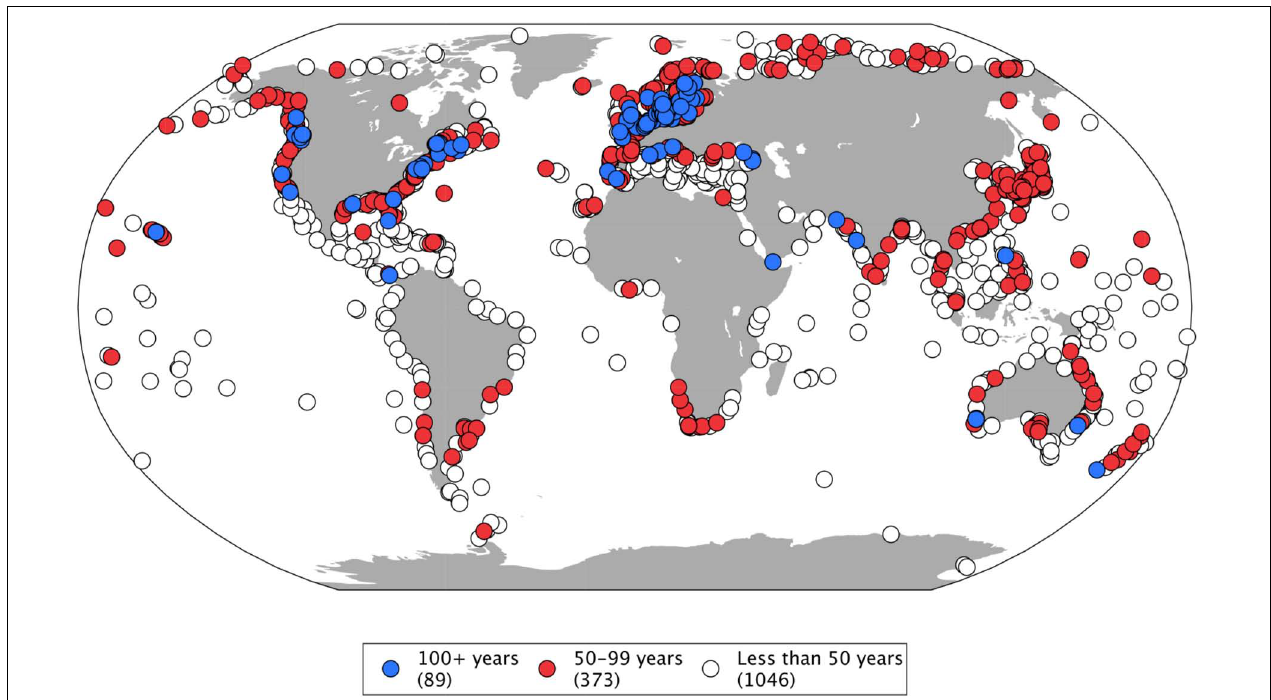
FIGURE 2 | Tide gauge monthly sea level records available at PSMSL. In color, time series longer than 50 (red) and 100 (blue) years. Number of stations in each category is given in